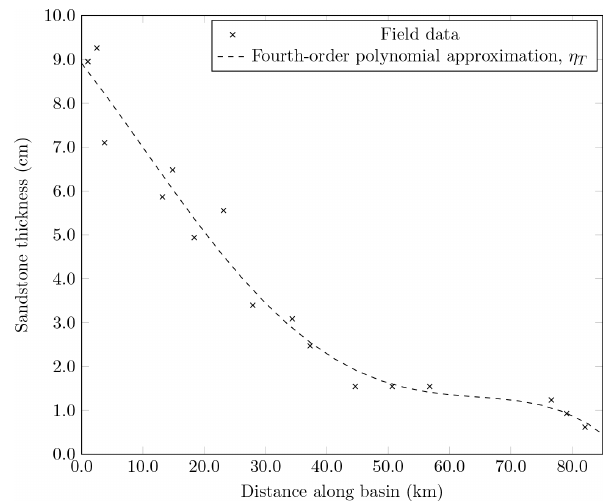
Figure 5. The sandstone depths measured for Bed 1.1 along the Pietralunga and Ridracoli structural elements orientated approxi- mately parallel to the palaeoflow. This has been reconstructed from Fig. 5 in Talling et al. (2007a). A fourth-order polynomial approx- imation of the deposit profile, η T , is also shown. This is used as a target for the optimisation algorithm. The base of the bed is shown as a horizontal datum in order to illustrate lateral changes in deposit thickness. Note that a different datum is used in the source figure, which uses the top of Bed 1.2.2 rather than the top of Bed 1. The palaeoelevation of the base of the bed would have varied spatially, reflecting the basin floor